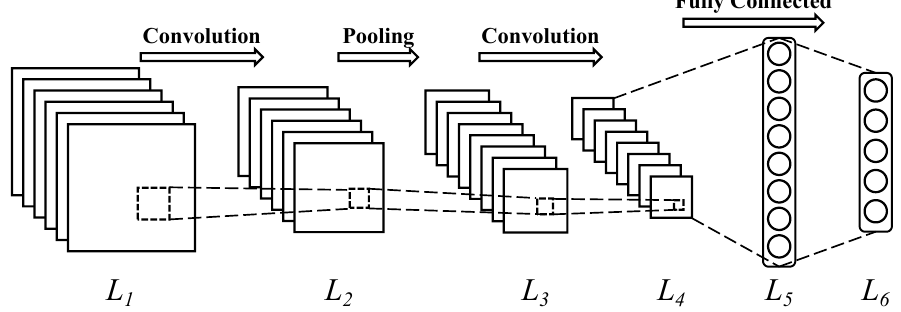
Figure 6. A spiking convolutional neural network with six